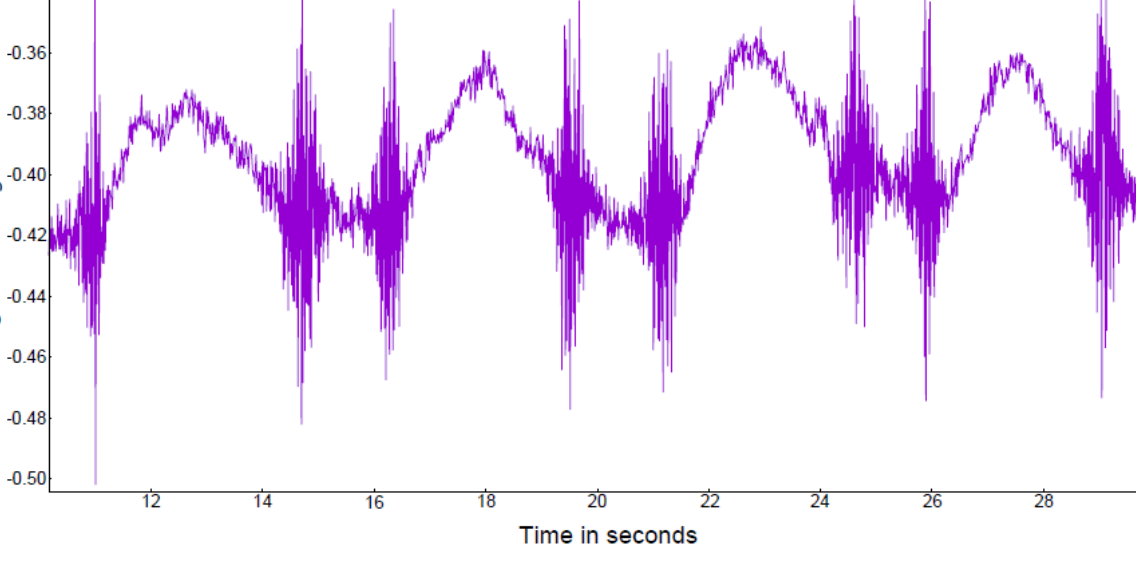
Note . Pronounced peaks mark the passage through the center of the